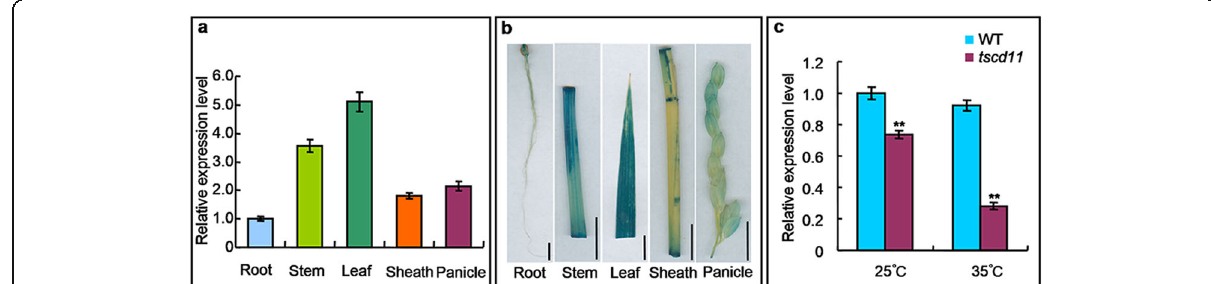
Fig. 5 Expression pattern of TSCD11 . a , qRT-PCR analysis of TSCD11 gene in various tissues of wild-type plants. Data represent the mean ± SD (n = 3). b , GUS staining of root, stem, leaf, sheath and panicle in the TSCD11 promoter-GUS transgenic plants (bars =1 cm). c , Relative transcript levels of TSCD11 in the WT and tscd11 at the 3-leaf stage grown at 25 °C and 35 °C, respectively. The rice Histone gene was used as an internal control. The expression level of TSCD11 in the WT at 25 °C was set to 1.0. Data represent mean ± SD (n = 3). ** p < 0.01 (Student ’ s t